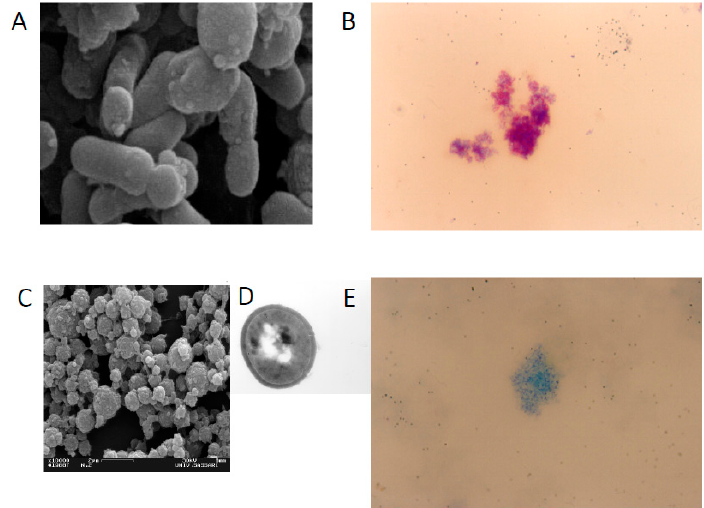
Figure 1. Scanning electron microscopy and Ziehl Neelsen staining of MAP cells IS900 positives growth in absence of Lysozime ( A , B , respectively) with a bacillary shape and wild type cell wall. Scanning, Transmission electron microscopy and Ziehl Neelsen staining of MAP cells IS900 positives growth in presence of Lysozime when the bacteria lost the cell wall that takes up the characteristic acid stain ( C – E respectively) with a round shape and cell wall deficient form.